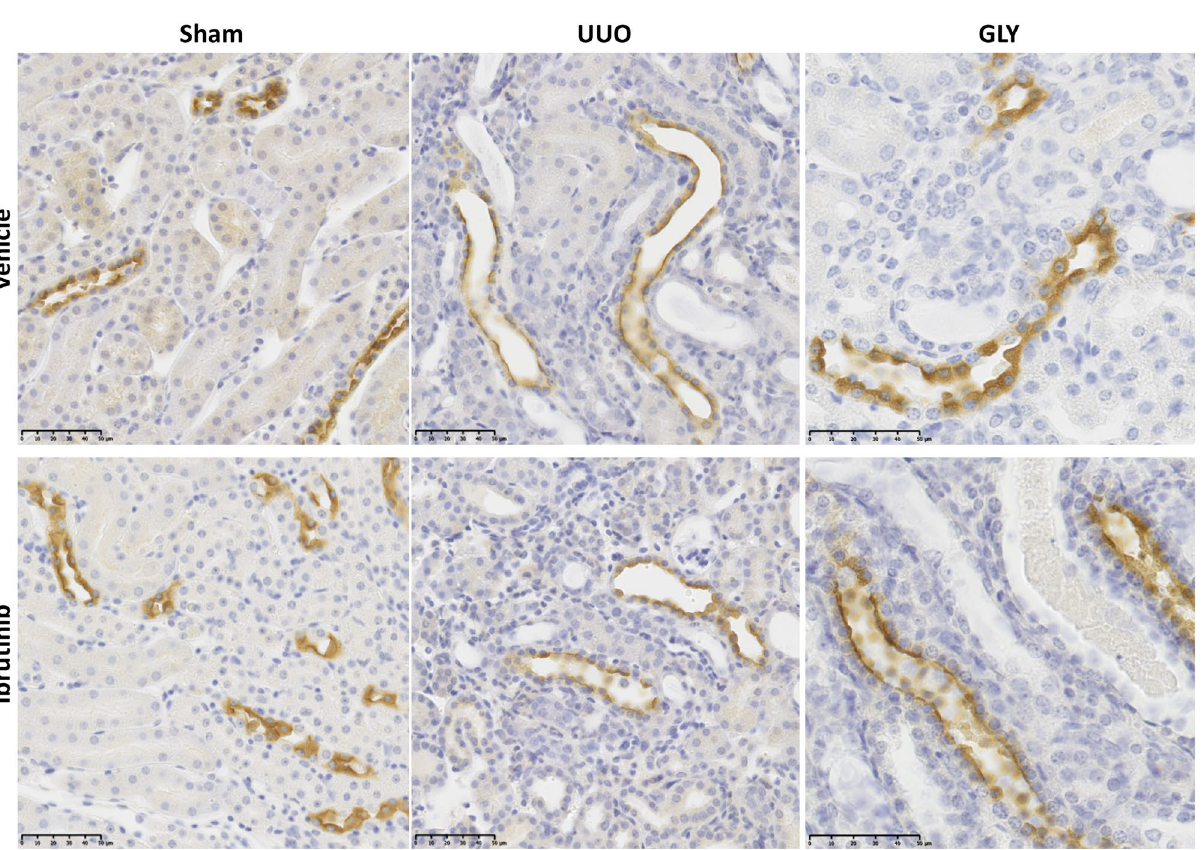
Figure 4. Kidney expression of BTK in sham and after glycerol-induced rhabdomyolysis (day 2; GLY) or unilateral ureteric obstruction (day 7,